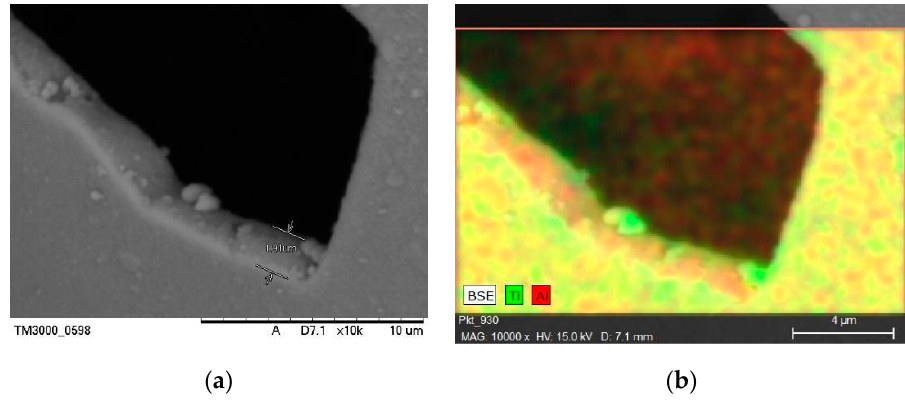
Figure 7. Scanning electron microscope (SEM) microphotographs of FAC with TiO 2 : ( a ) SEM image, ( b ) energy-dispersive X-ray spectroscopy (EDS) mapping.